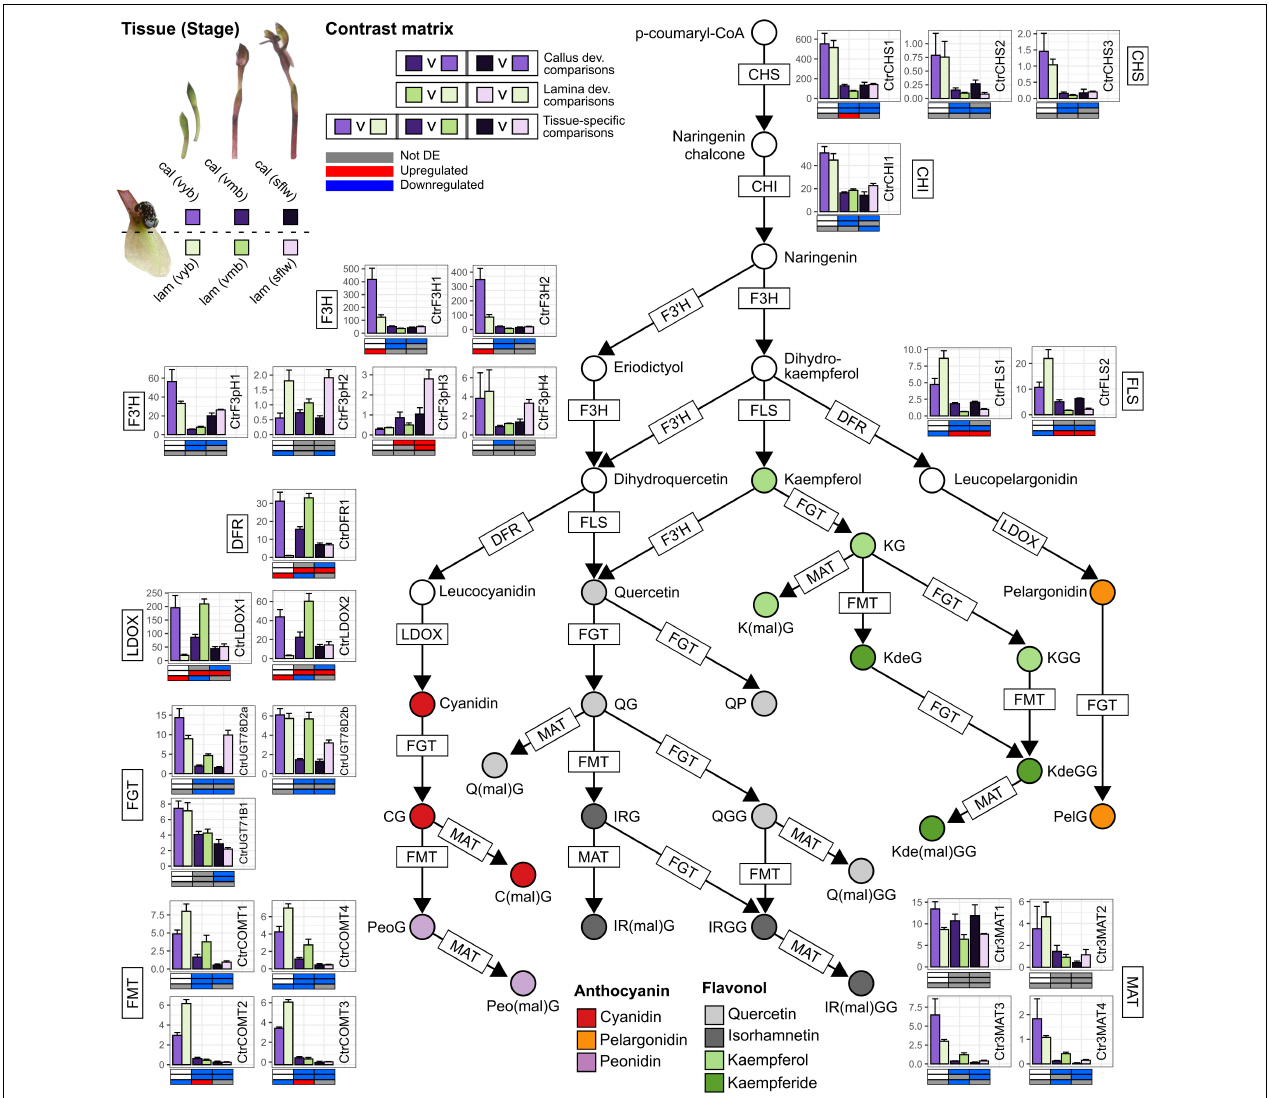
FIGURE 3 | Anthocyanin and flavonol metabolism in the callus and labellum tissues of Chiloglottis trapeziformis during flower development. Bars depict the average ( ± s.e.) normalized expression values (FPKM) of anthocyanin and flavonol biosynthesis and modification pathway genes in the calli and labellum lamina tissues of very young buds ( vyb ), very mature buds ( vmb ), and mature sunflowers ( sflw ). Colored circles indicate putative anthocyanins and flavonols identified in Chiloglottis trapeziformis callus (cal) and labellum lamina (lam) tissues ( Table 1 ). Various shades of purple and green depict the relevant color callus and labellum lamina tissues at various flower developmental stages. The contrast matrix indicates the differential expression outcomes based on comparisons in Supplementary Figure 1 . Red, blue, and gray indicate significant upregulation (FDR < 0.05, log 2 FC > 0.5), downregulation (FDR < 0.05, log 2 FC < –0.5), and no significant differential expression in selected comparisons, respectively. CHS, Chalcone synthase; CHI, Chalcone isomerase; F3H, Flavanone 3-hydroxylase; F3 (cid:48) H, Flavonoid 3 (cid:48) -hydroxylase; F3 (cid:48) 5 (cid:48) H, Flavonoid 3 (cid:48) 5 (cid:48) -hydroxylase; DFR, Dihydroflavonol 4-reductase; LDOX, Leucoanthocyanidin dioxygenase; FLS, Flavonol synthase; FGT, Flavonoid/anthocyanin glucosyltransferase; FMT, Flavonoid/anthocyanin O-methyltransferase; MAT, Flavonoid/anthocyanin